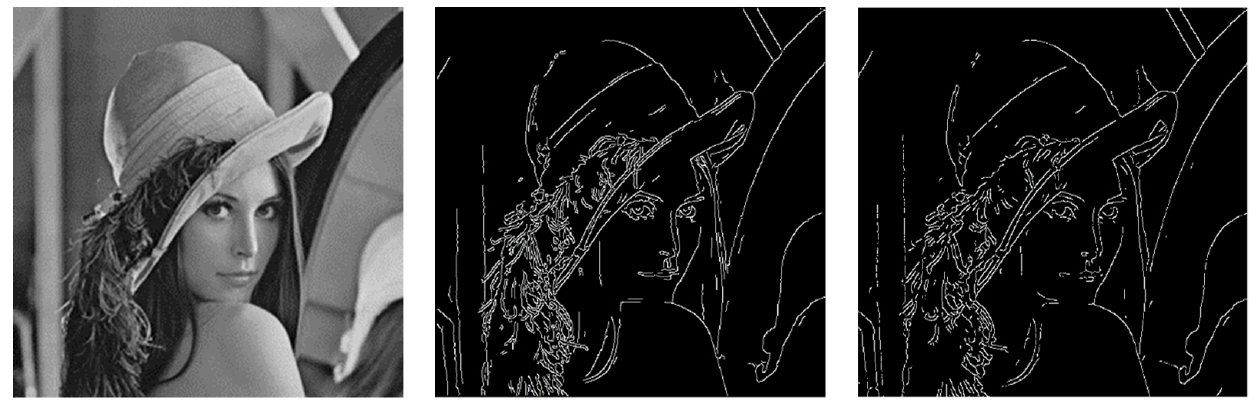
Figure 20. Edge map: Left: original image; Middle: Edge map without using the logarithm approxi-